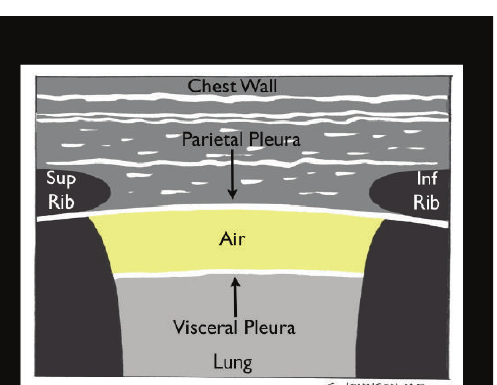
Figure 19: Pulmonary edema B-lines.